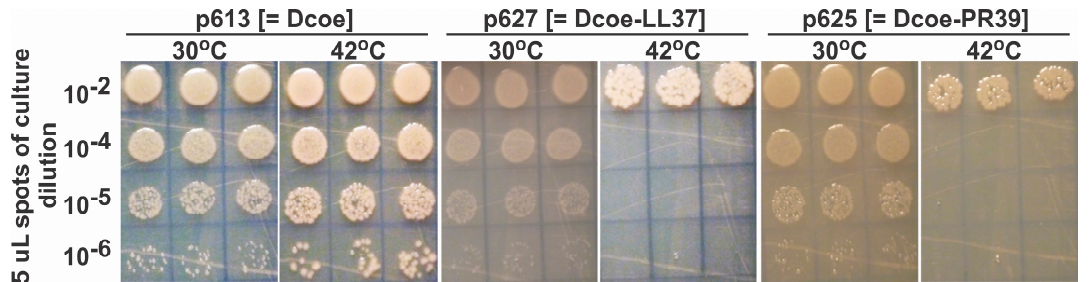
Figure 3. The expression of the D -fused pig PR39 [36], or human LL37 [32 – 35] cathelicidins killed/prevented the growth of E. coli cells expressing the D -fusions. Single colonies of cells with plasmid p613 (pcIpR- D coe-timm), p625 (pcIpR- D coe-PR39-timm, where D was fused to a 42 AA pig cathelicidin), and p627 (pcIpR-Dcoe-LL37-timm, where gpD was fused to the 39 AA human cathelicidin) were inoculated into LB-Amp50 medium (Methods and grown at 30 °C in shaking water bath to stationary phase. A 1-mL aliquot was removed and serially diluted into buffer (Methods), and 5-uL aliquots of the dilutions were spotted in quintuplicate onto LB-Amp50 agar plates, one heated to 30 °C and the other to 42 °C, and then moved to the respective incubators for the spots to dry with lids ajar, then inverted with continued incubation overnight. Titers were determined by averaging the cfu (visualized by dissecting microscope) per five spots X dilution factor X 200.